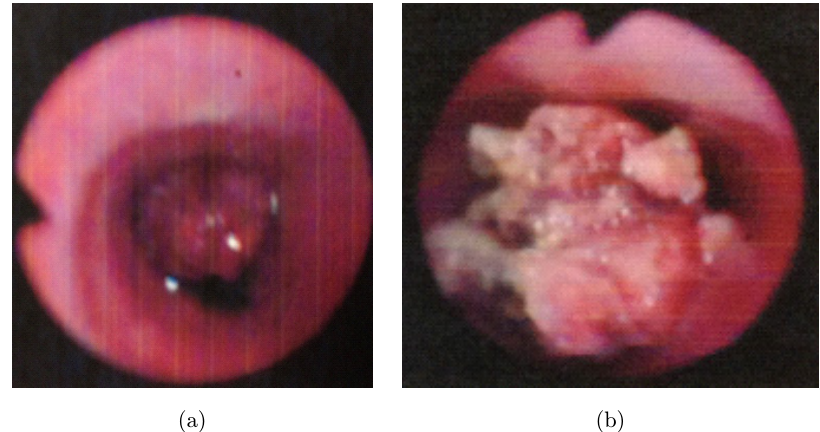
Fig. 1. Typical diagrams of a single malignant tumor in the lower segment of trachea before or after treatment with the MTC. (a) Before treatment; (b) During the 4th treatment process; (c) Before the 5th treatment; (d) After the 5th